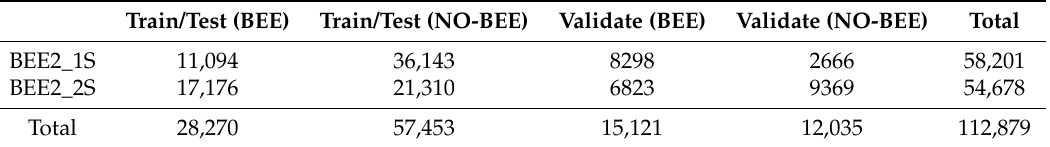
Figure 8. A sample of 2-super images from BEE2 (BEE2_2S). The first four rows include images classified as BEE. The last three rows consist of images classified as NO-BEE. Table 1. Numbers of images in BEE2_1S and BEE2_2S (collectively referred to as BEE2) used for training, testing, and